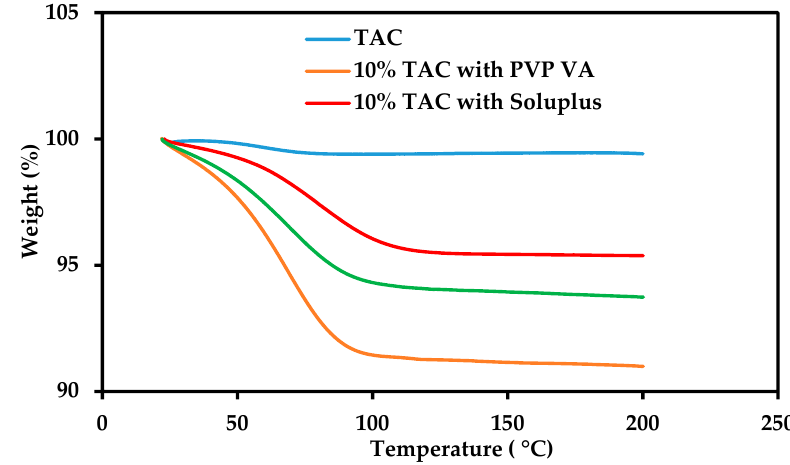
Figure 2. TGA of crystalline TAC and physical mixtures with PVP-VA 64, Soluplus and HPC containing 10% w / w TAC.